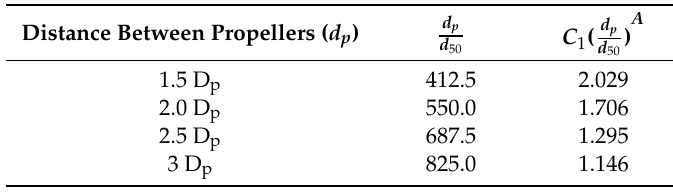
(cid:19) A (cid:18) d p . d 50